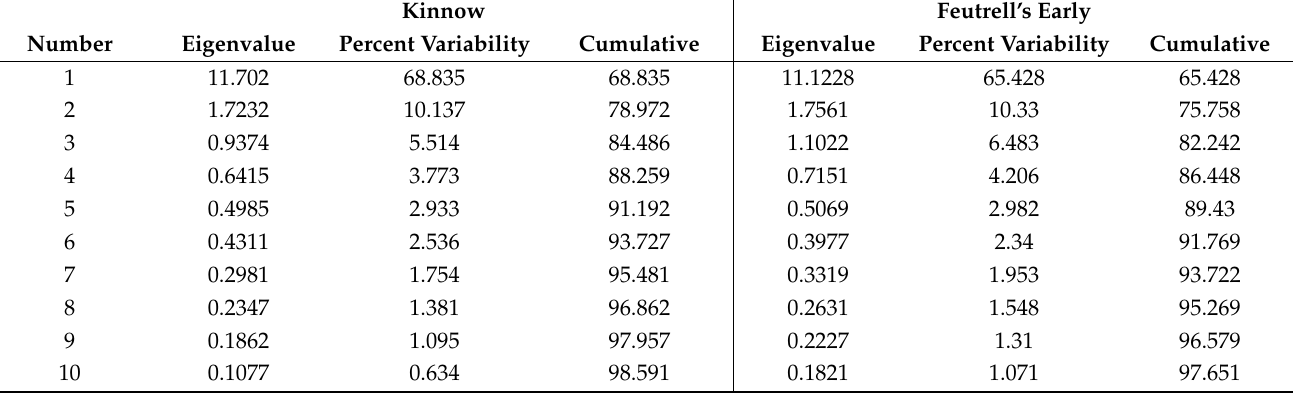
Table 2. Eigenvalues and proportion of total variability among fruit quality characters as explained by the first 10 principal components for Kinnow and Feutrell’s Early.